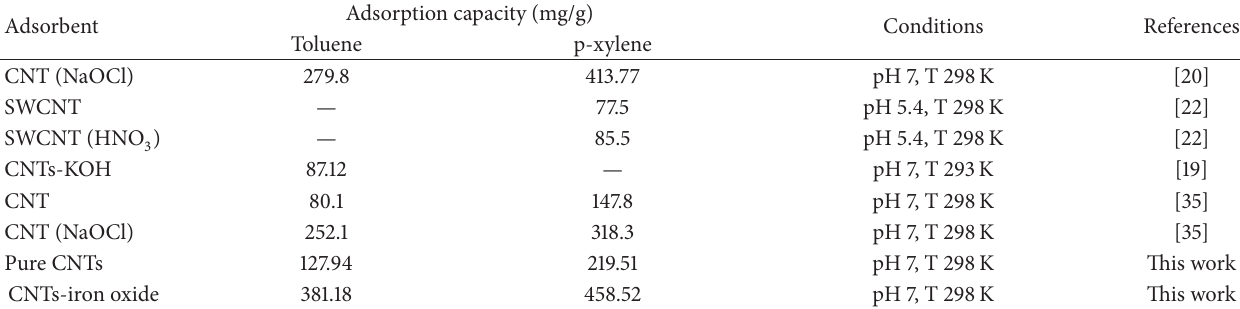
Table 4: Comparison of adsorption capacity of different CNTs based adsorbents for toluene and p-xylene removal.